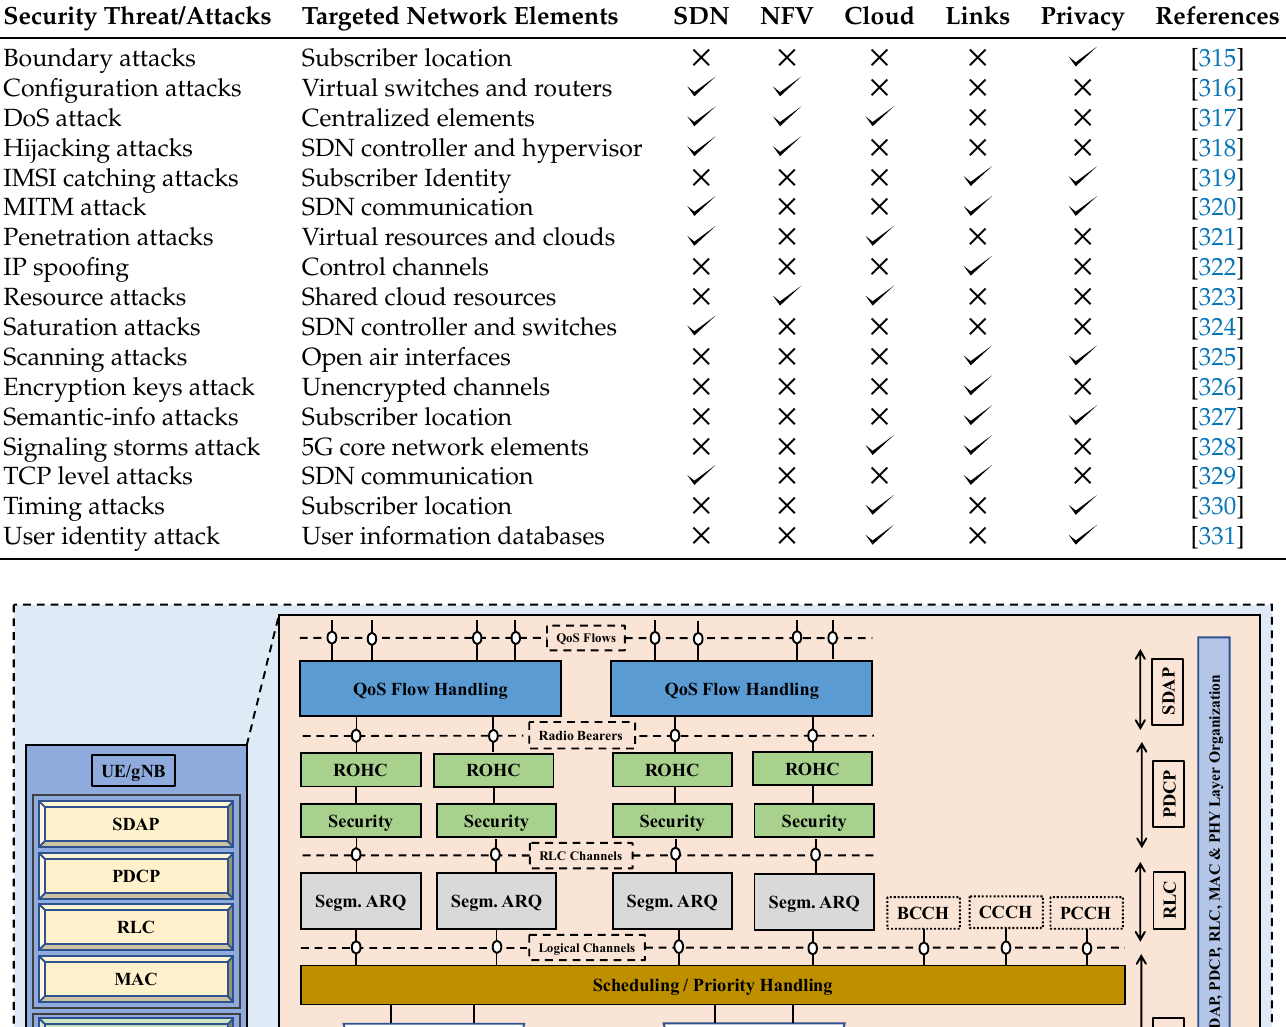
Table 10. Summary of studies on 5G security and privacy threats.